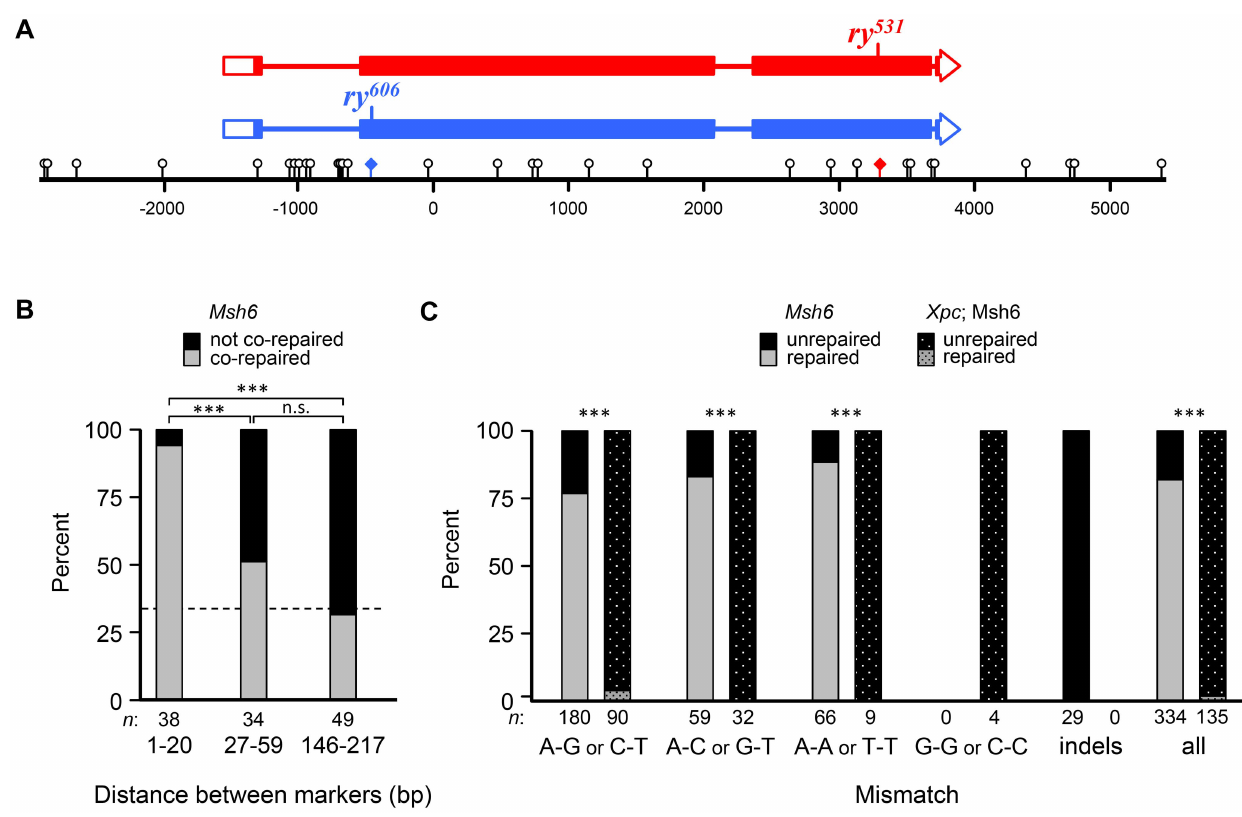
Figure 3. Short-patch co-repair frequencies are consistent with NER tracts. ( A ) Schematic of the rosy locus used to recover tracts of hDNA. Boxes represent exons and filled regions denote coding sequences. Locations of mutants are indicated on the schematics and shown on the scale bar as colored diamonds. Markers used to map hDNA tracts are shown as lollipops on the scale bar (distances in base pairs, bp). See Materials and Methods for details. ( B ) Percentage of adjacent markers that are co-repaired and not co-repaired for different distances. Bars show the percentage in each class (gray, co-repaired; black, not co-repaired) for different ranges of distance between markers. The dotted line represents the expected frequency of co-repair if adjacent markers are repaired independently. The shortest distance class is within the range of NER excision tract size. ( C ) Frequency of repair of different mismatches in Msh6 and Xpc ; Msh6 mutants. Bars represent percentage of each mismatch type that were repaired (gray) or unrepaired (black). Since DSBs likely occur at different, unknown sites, we cannot tell which of two possible mismatches was in the hDNA of the intermediate (though this can be inferred for trans hDNA in Xpc ; Msh6 mutants). Msh6 data in (B) and (C) are from Radford et al. (2007b). NCOs that had full gene conversion with no unrepaired sites were not included, since these might arise through other mechanisms (see Figure S1); however, including these tracts did not change the outcome in either case. ***, P , 0.0001; n.s., P . 0.05 (two-sided Fisher’s exact test).